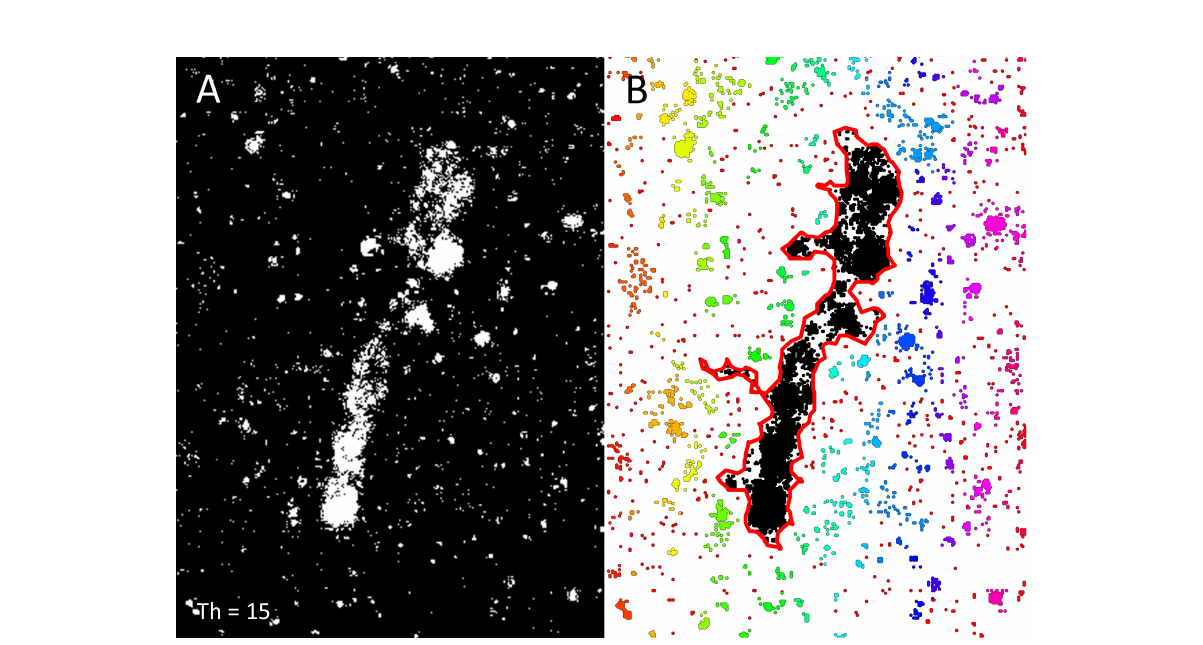
FIGURE 4 (A) Binarization of a shadowgraph of the amorphous marine aggregate (Figure 3) at threshold = 15. Parts of the mucous matrix are not detected at this threshold. (B) Density-based spatial clustering (Ester et al., 1996) assigns the same index value to components of the particle (black) so that a boundary function (red line) can envelope the entire marine snow particle. In such fashion, a more accurate size and shape determination can be performed on fragmented structures. Colors other than black represent more loosely de fi ned particle